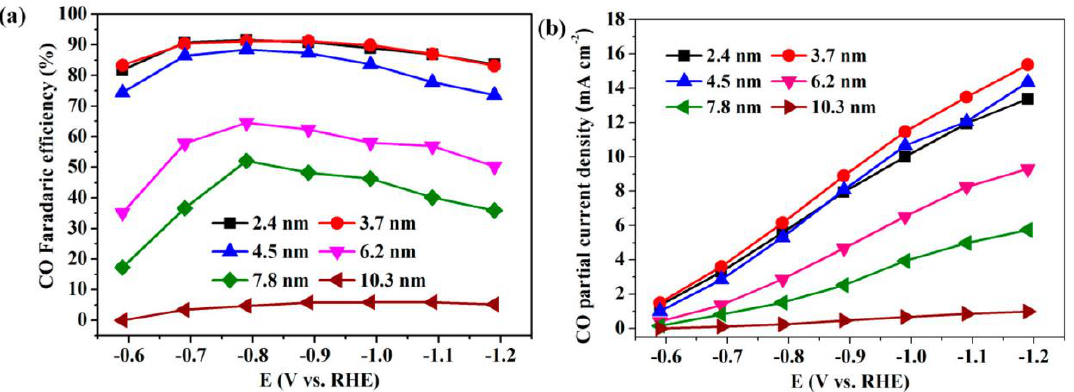
Figure 8. Applied potential dependence of ( a ) Faradaic efficiencies and ( b ) current densities for CO production over Pd NPs with different sizes. Reprinted from Ref. [113], copyright (2015), with permission from the American Chemical Society.